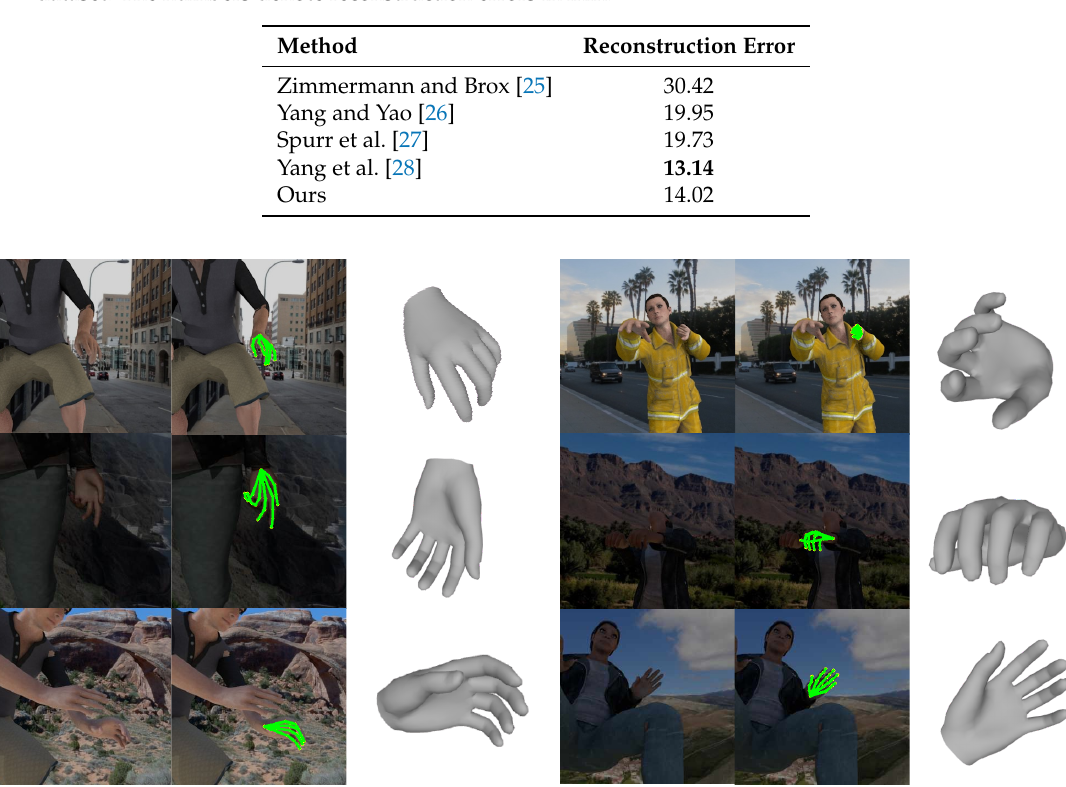
Figure 10. Qualitative results on the RHD